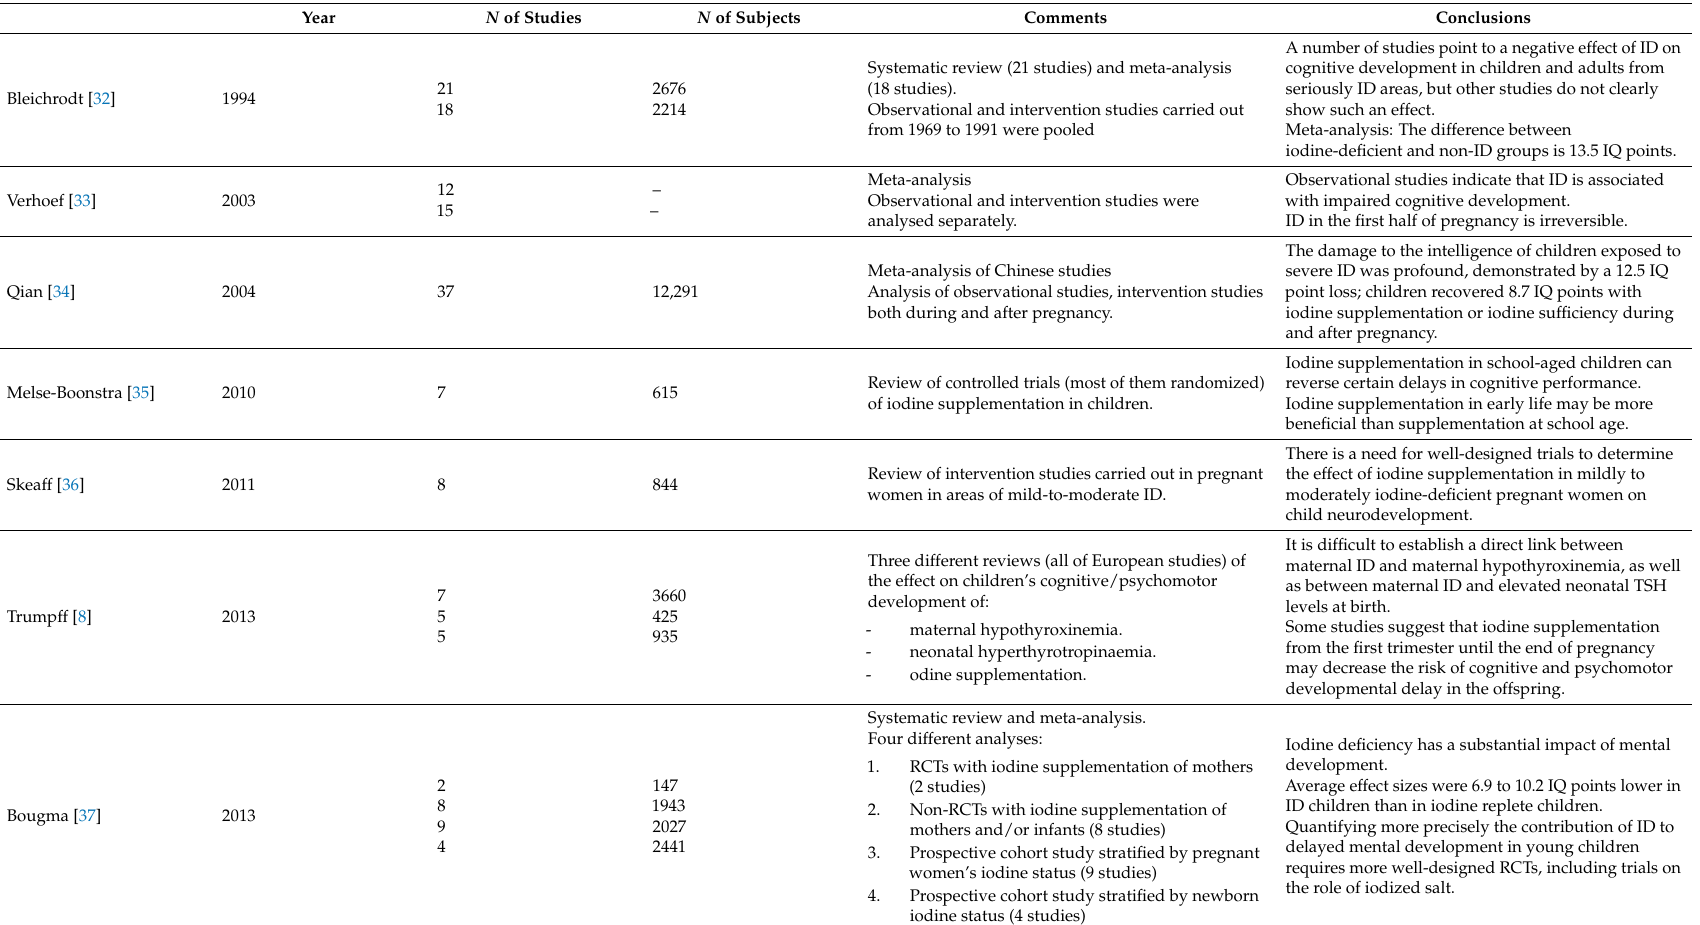
Table 2. Reviews and meta-analyses of the effect of iodine deficiency (ID) on cognitive and neuropsychological